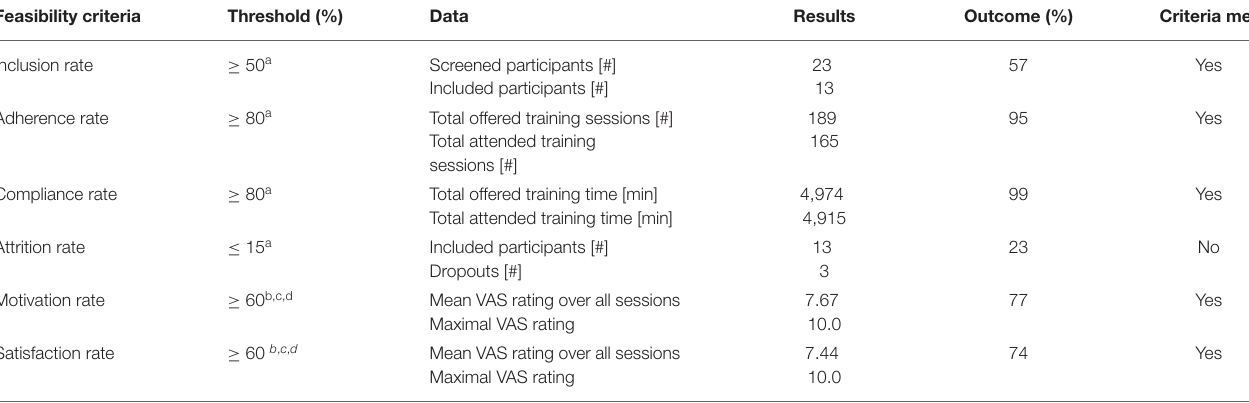
TABLE 3 | Feasibility results.